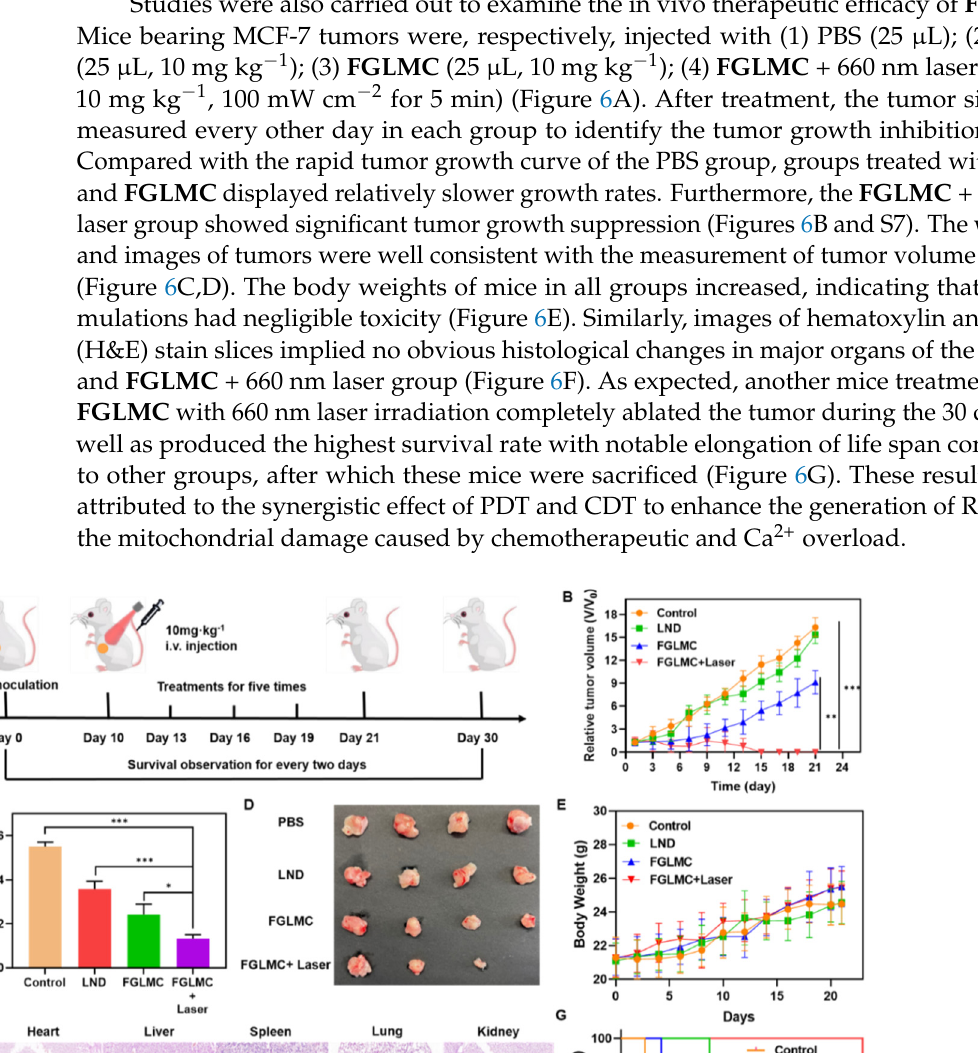
Figure 5. Migration and invasion evaluation. ( A ) Wound healing assay and ( B ) anti-invasion ef- fects of different formulations on MCF-7 cells (The distance between the red dotted lines is the cell spacing after different treatments). ( C ) Western blot analysis for the expression of Prx3 and PINK1 on MCF-7 cells treated with different formulations. GAPDH was used as the loading control. Quantification of Prx3 ( D ) and PINK1 ( E ) expression intensity. Data are presented as mean ± SD (** p < 0.01, *** p < 0.005)